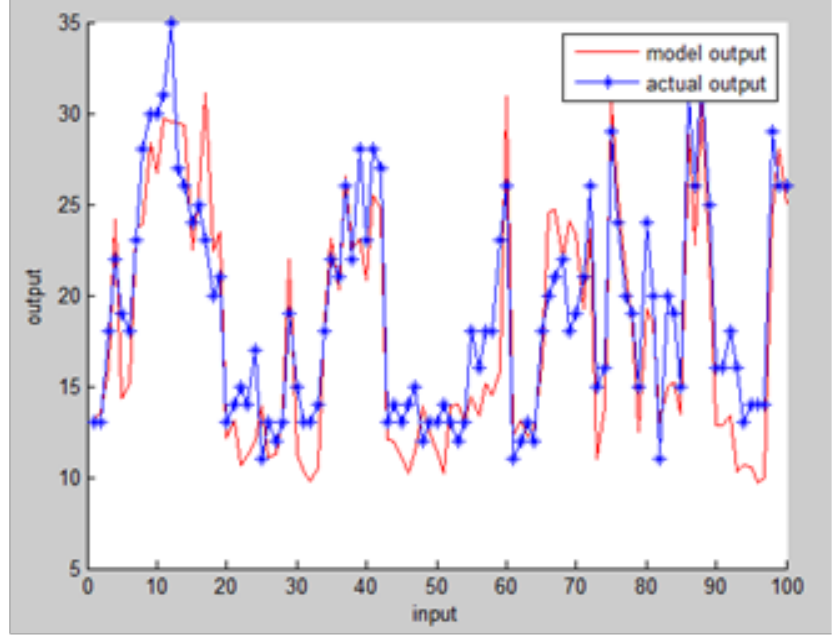
Figure 8. The comparison of model output and actual output.